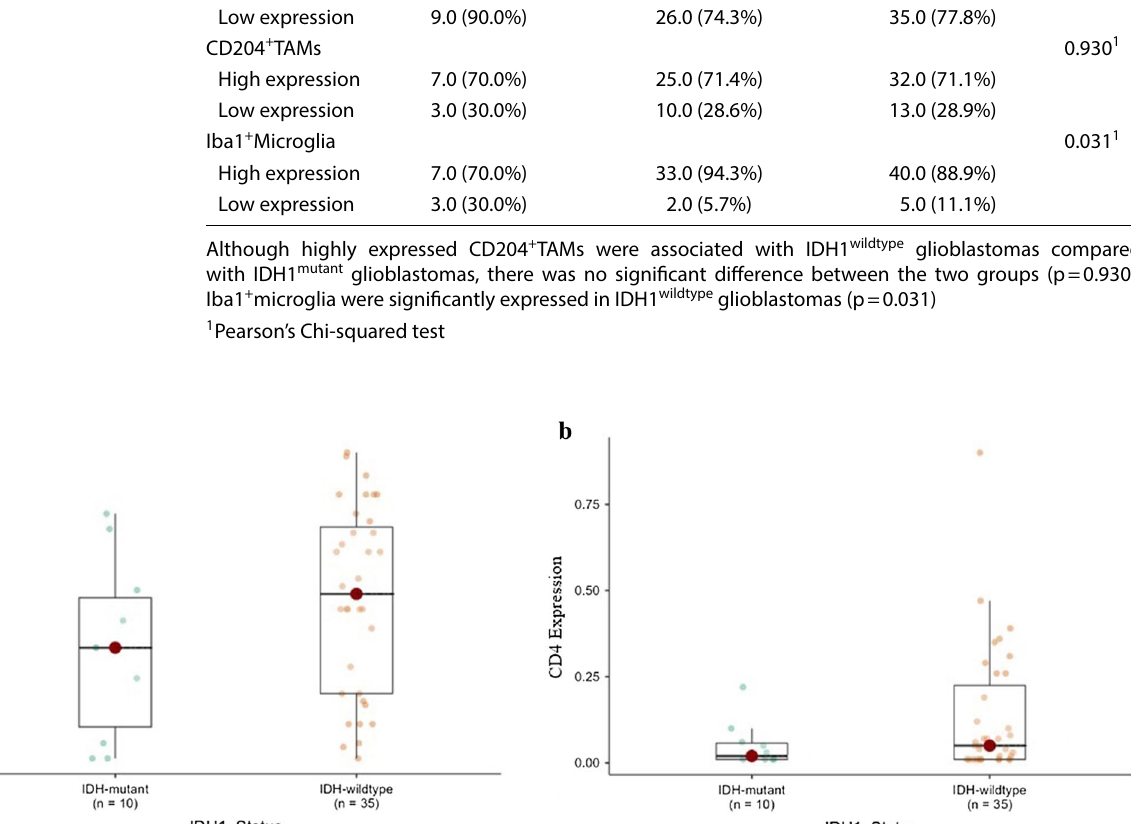
Table 5 Relationship between CD204 + TAMs, CD4 + TILs, and Iba1 + Microglia with IDH1 mutant glioblastomas